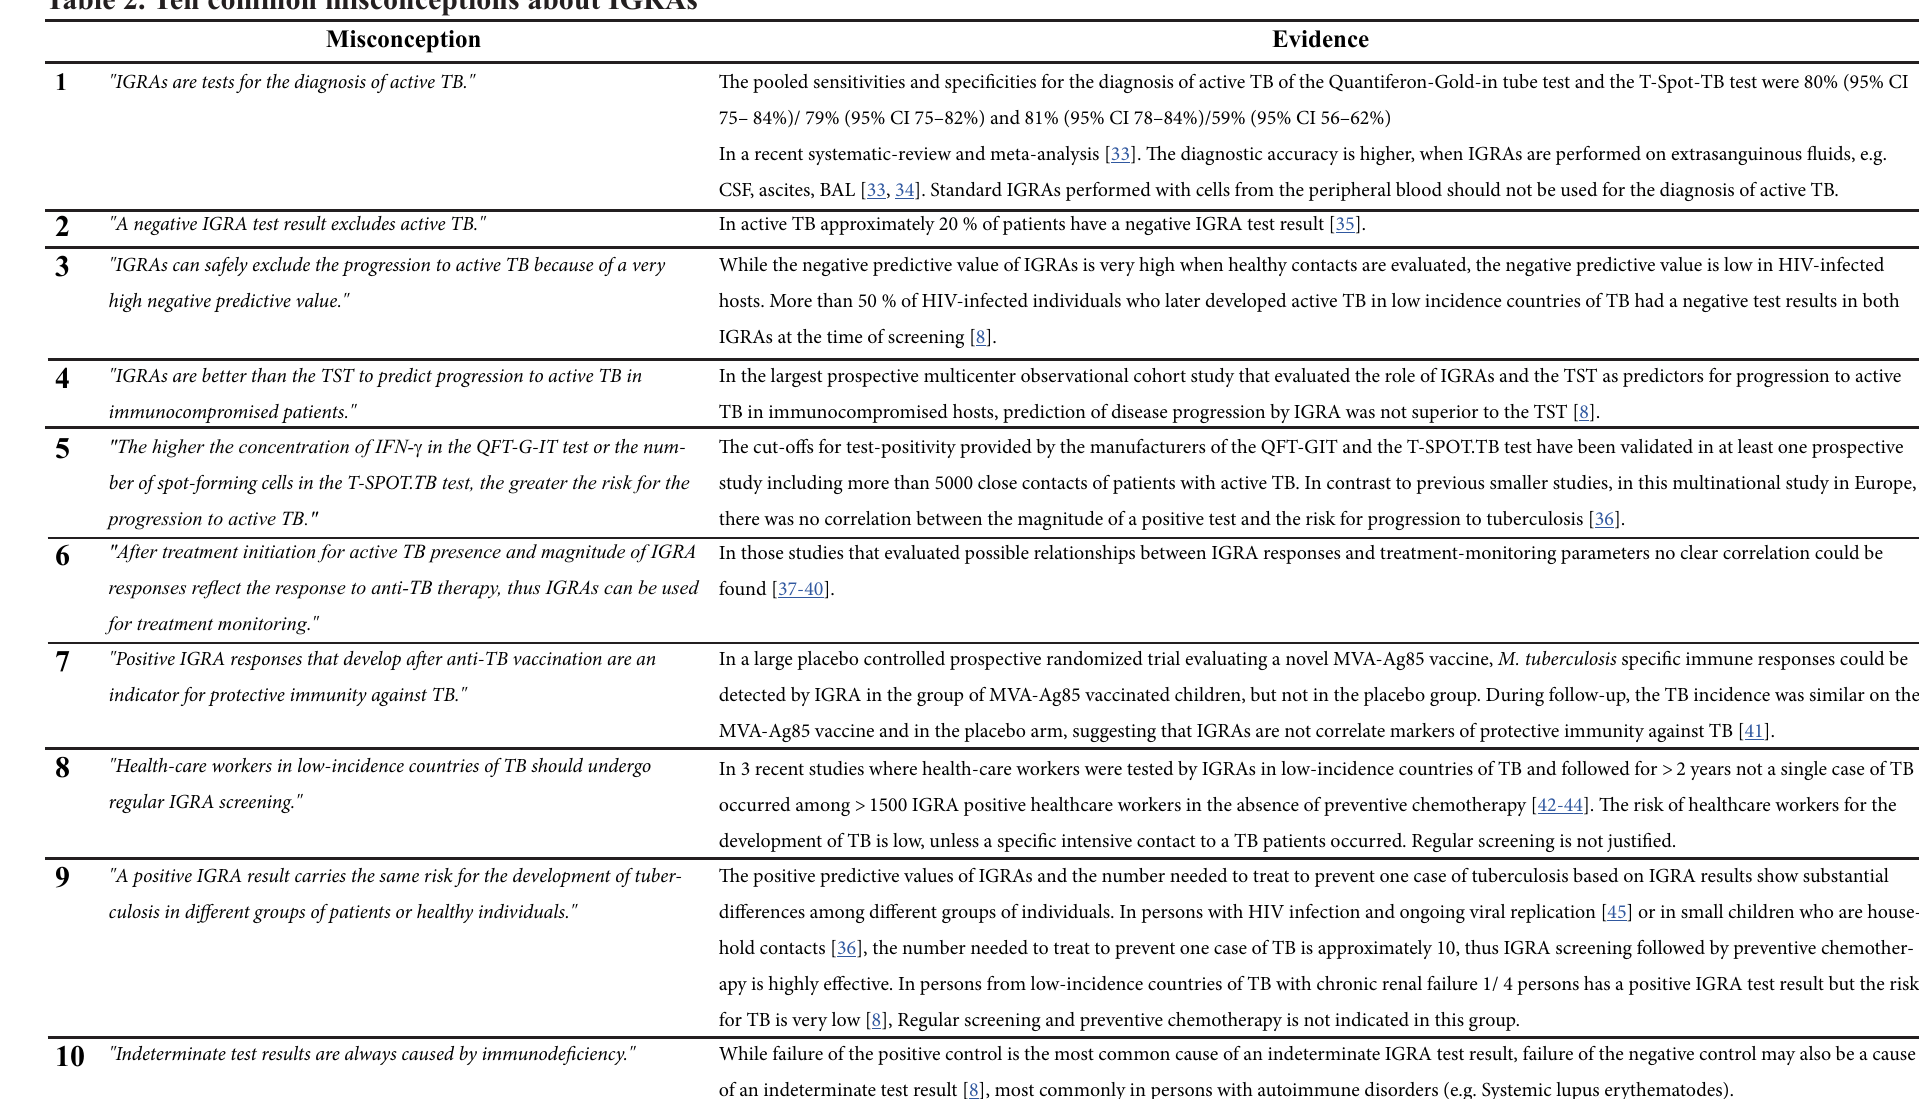
Table 2. Ten common misconceptions about IGRAs Misconception